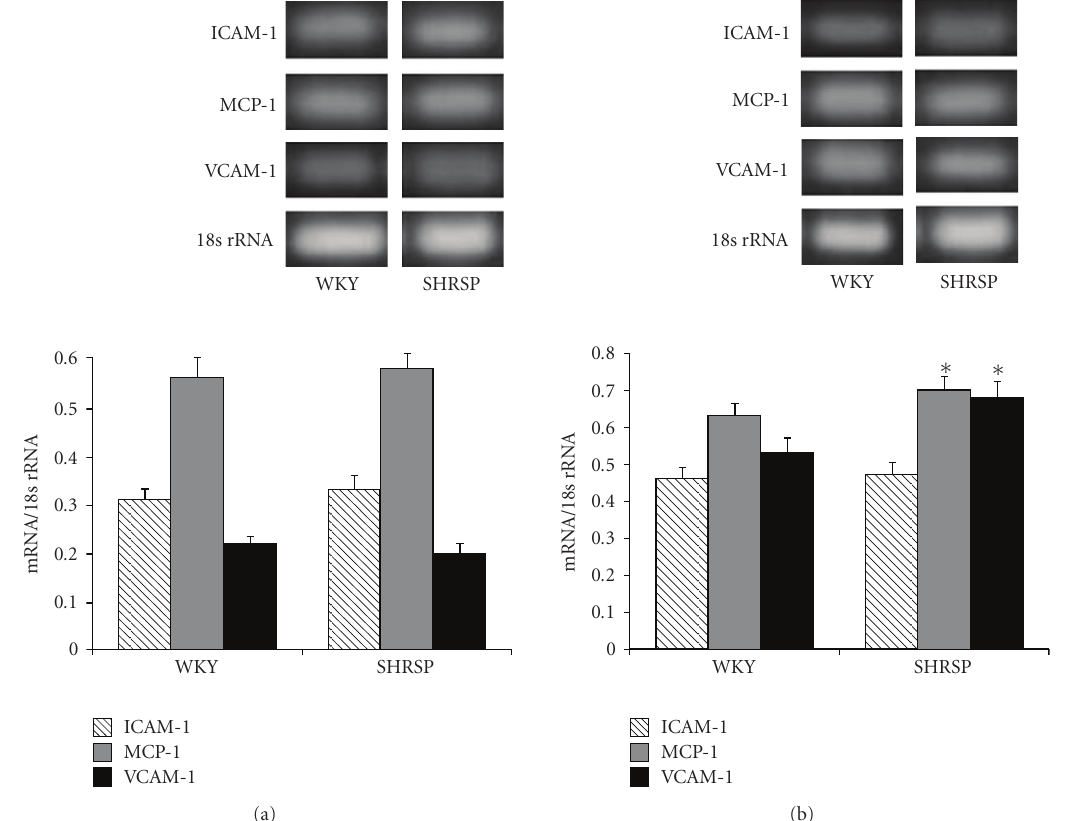
Figure 1: A comparison between the gene expression levels of ICAM-1, MCP-1, and VCAM-1 in astrocytes isolated from WKY/IZM and SHRSP/IZM. The astrocytes isolated from WKY/IZM and SHRSP/IZM were washed with FBS-free DMEM, before TNF- α was added (a) or not added (b) at 4 hours. Total cellular RNA was isolated from cultured astrocytes. The RNA was transcribed with reverse transcriptase and amplified by RT-PCR. An 18s ribosomal RNA amplicon was used as an internal control for quantitation of the total amount of cDNA. The bars represent the mean ± SD ( n = 4). Asterisk ( ∗ ): P < . 05 compared with the WKY/IZM value. WKY: WKY/IZM; SHRSP: SHRSP/IZM.